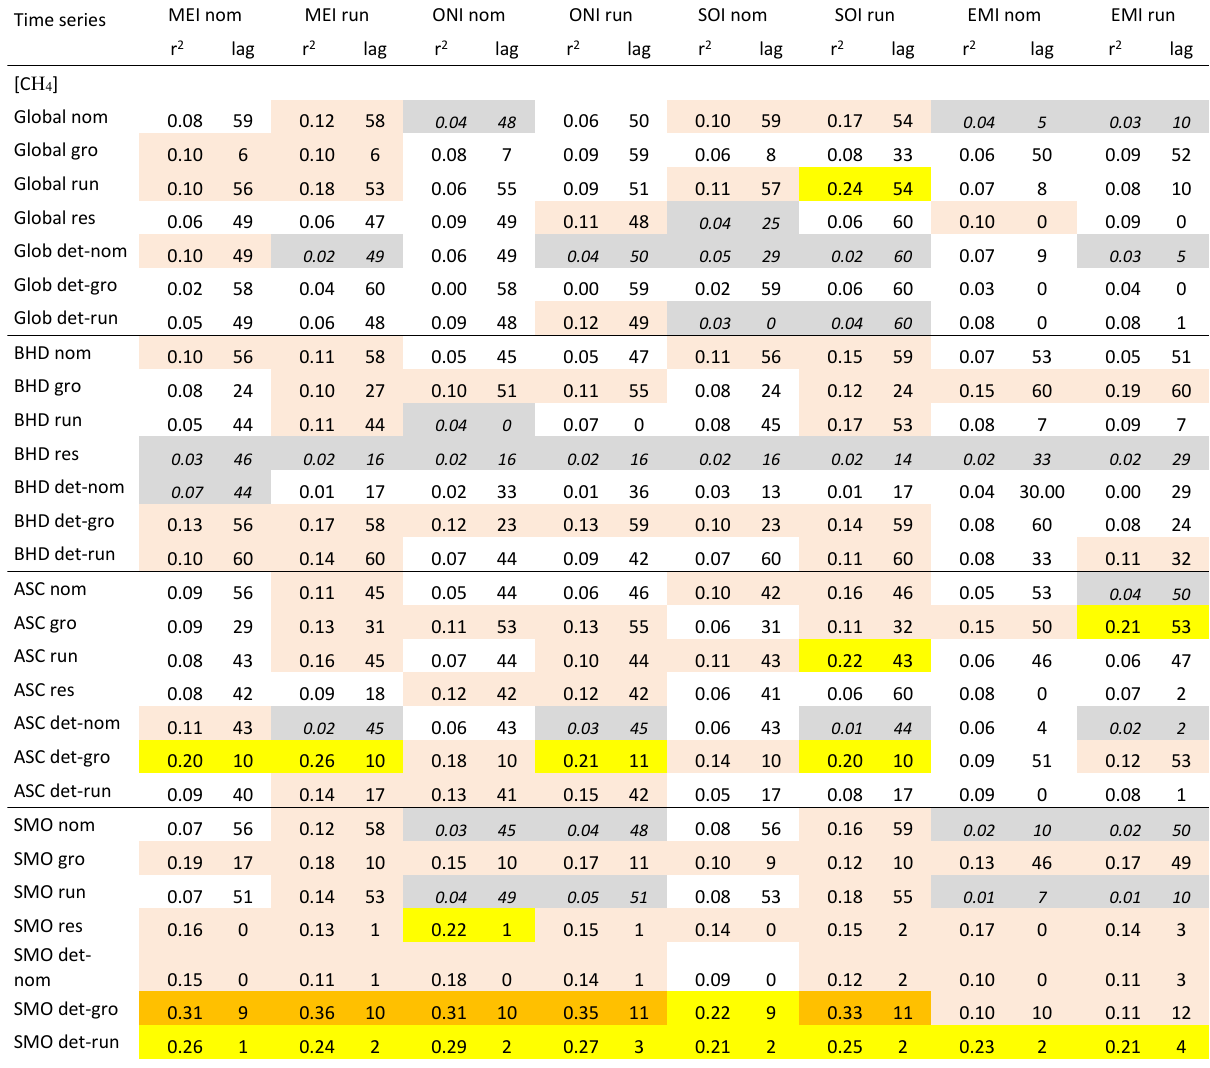
Table 2: Spearman correlation of methane mole fraction with ENSO variability. Correlations (r 2 -values) for the Spearman ranking coefficient between [CH 4 ] time series from various sites and ENSO indices with lag times (in months) for optimum results. Colour backgrounds indicate r 2 -values in 10% classes. Grey background indicates correlations with p-values > 0.001.